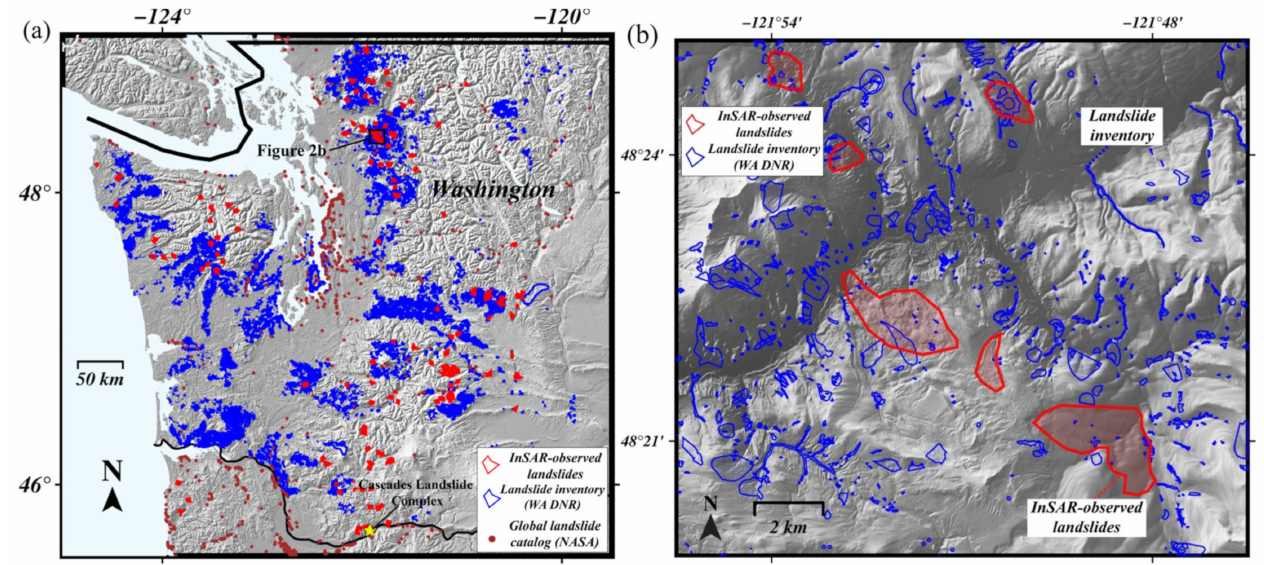
Figure 2. ( a ) Comparison of InSAR-observed landslides (red-outlined polygons) in Washington and landslide inventory (blue-outlined polygons) from Washington Department of Natural Resources (DNR; https://geologyportal.dnr.wa.gov accessed on 21 April 2021). ( b ) An enlarged region (box in Figure 2a) illustrates the differences in detail. Landslide inventory (blue polygon) displays the location and extent of past landslides of all kinds (avalanches, runout, deep-seated landslides) but InSAR observation (red polygon) presents those of currently active deep-seated